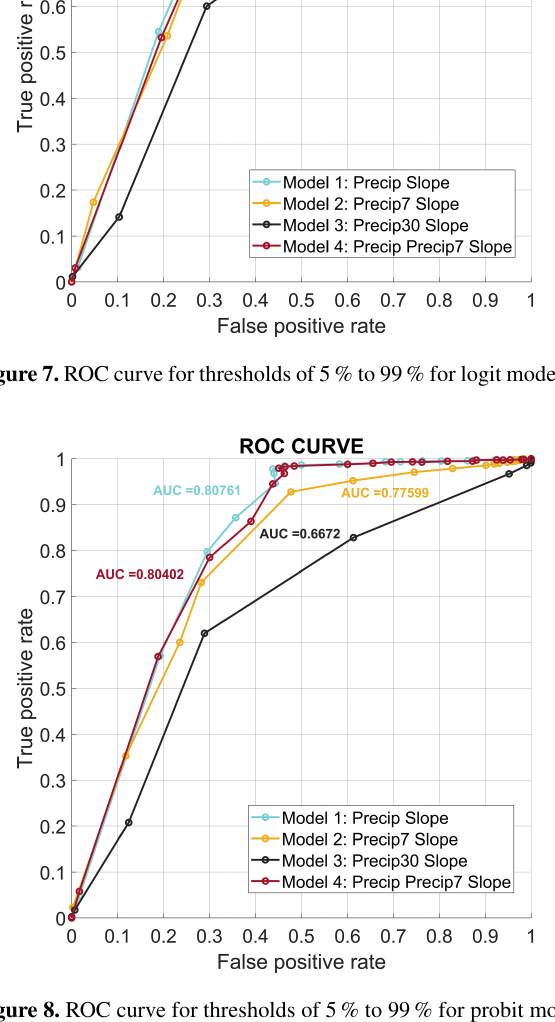
Figure 8. ROC curve for thresholds of 5% to 99% for probit mod- els.